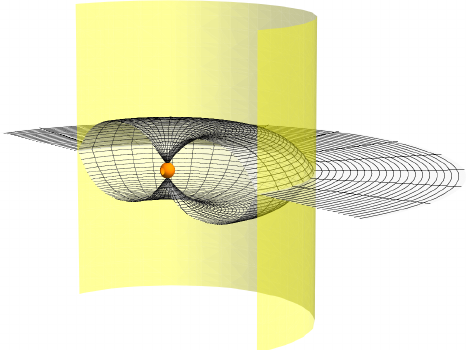
Figure A2. The structural backbone of an active magnetosphere for an aligned rotator (sliced in half). The semi-transparent yellow surface is the light cylinder, beyond which plasma cannot co-rotate with the star without going superluminal. The white meshed surfaces are the current sheets, with the two pieces within the light cylinder enclose the closed field lines region in which the plasma particles co-rotate. The field lines residing outside will penetrate the light cylinder and sweep back in the azimuthal direction, along which the particles stream (thus not co-rotating with the star). These out-flowing pulsar wind particles could cross the magnetic field lines in the outer regions where the magnetic field strength is weak, and return through the current sheets, completing a full circuit that maintains charge neutrality. The neutron star is depicted as an orange sphere at the center, whose size is, for illustrative purposes, massively enlarged from what should be for common